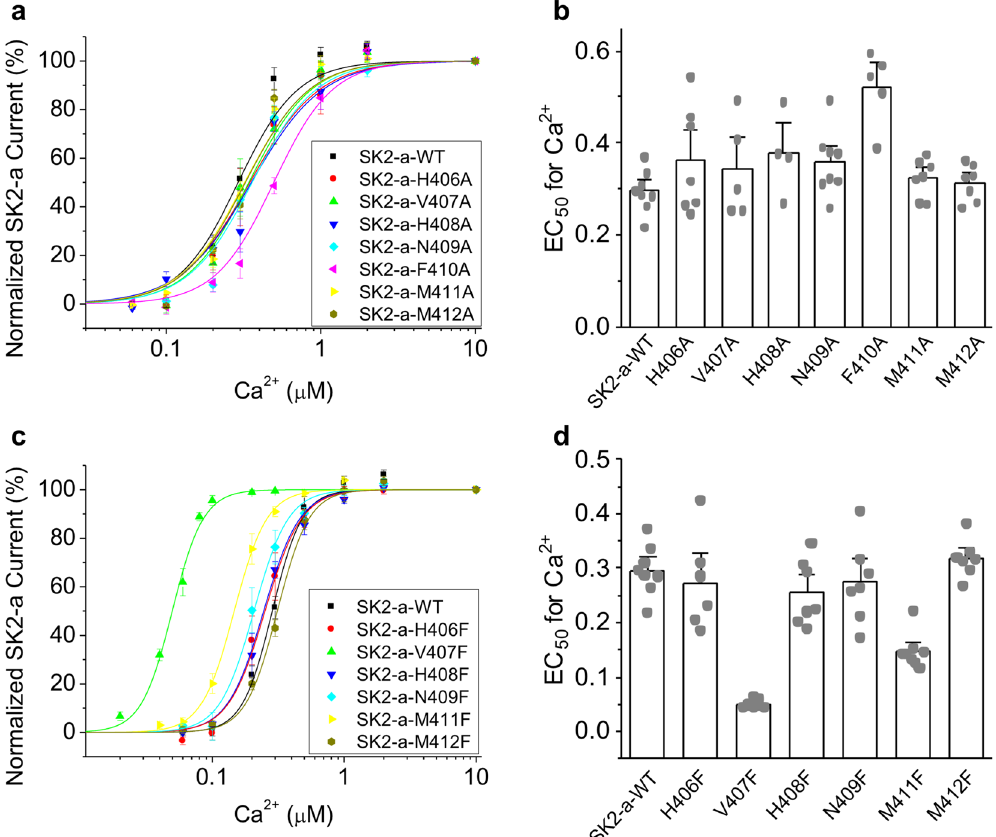
Figure 2. Mutations in the IDF change SK2-a channel Ca 2 + sensitivity. ( a ) Dose-dependent activation by Ca 2 + of the WT and alanine mutant SK2-a channels. ( b ) EC 50 values for activation by Ca 2 + of the WT and alanine mutant channels. ( c ) Dose-dependent activation by Ca 2 + of the WT and phenylalanine mutant SK2-a channels. ( d ) EC 50 values for activation by Ca 2 + of the WT and phenylalanine mutant channels. Statistical analysis